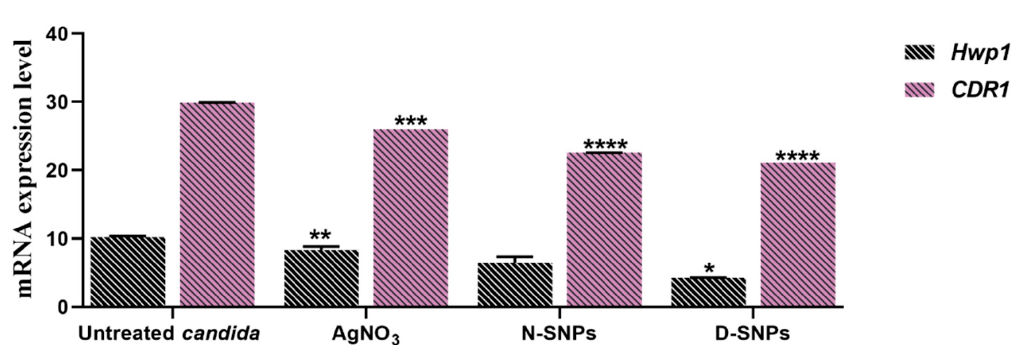
Figure 7. The mRNA expression levels of the Hwp1 and CDR1 genes in Candida albicans treated or not with AgNO 3 , N-SNPs, and D-SNPs. Data were collected from at least three independent assays and are presented as means ± SEM. **** p < 0.0001, *** p = 0.0001, ** p < 0.001, and * p = 0.01 vs. untreated C. albicans .